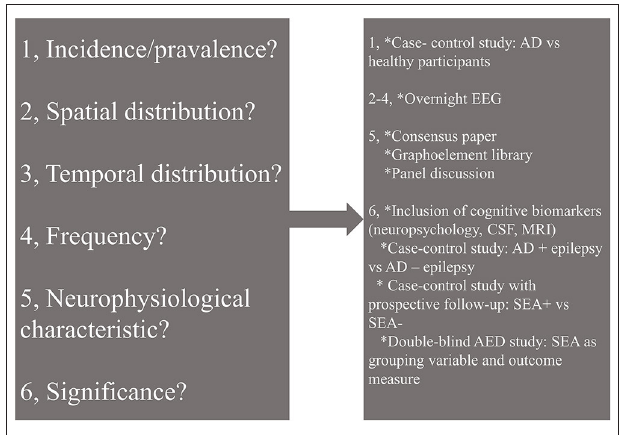
FIGURE 1 | Open questions (left) and possible solutions (right) in the research of subclinical epileptiform activity (SEA) in Alzheimer’s disease. AD, Alzheimer’s disease; EEG, electroencephalography; CSF, cerebrospinal fluid; MRI, magnetic resonance imaging; AED, antiepileptic drug; SEA, subclinical epileptiform